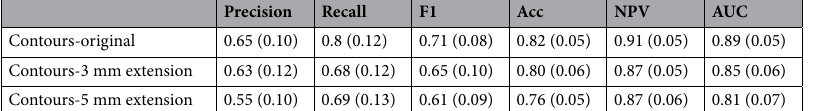
Table 2. The distinction of NTM lymphadenitis from other causes of lymphadenopathy. Reported results indicate the mean and standard deviation (in brackets) across 100 runs.